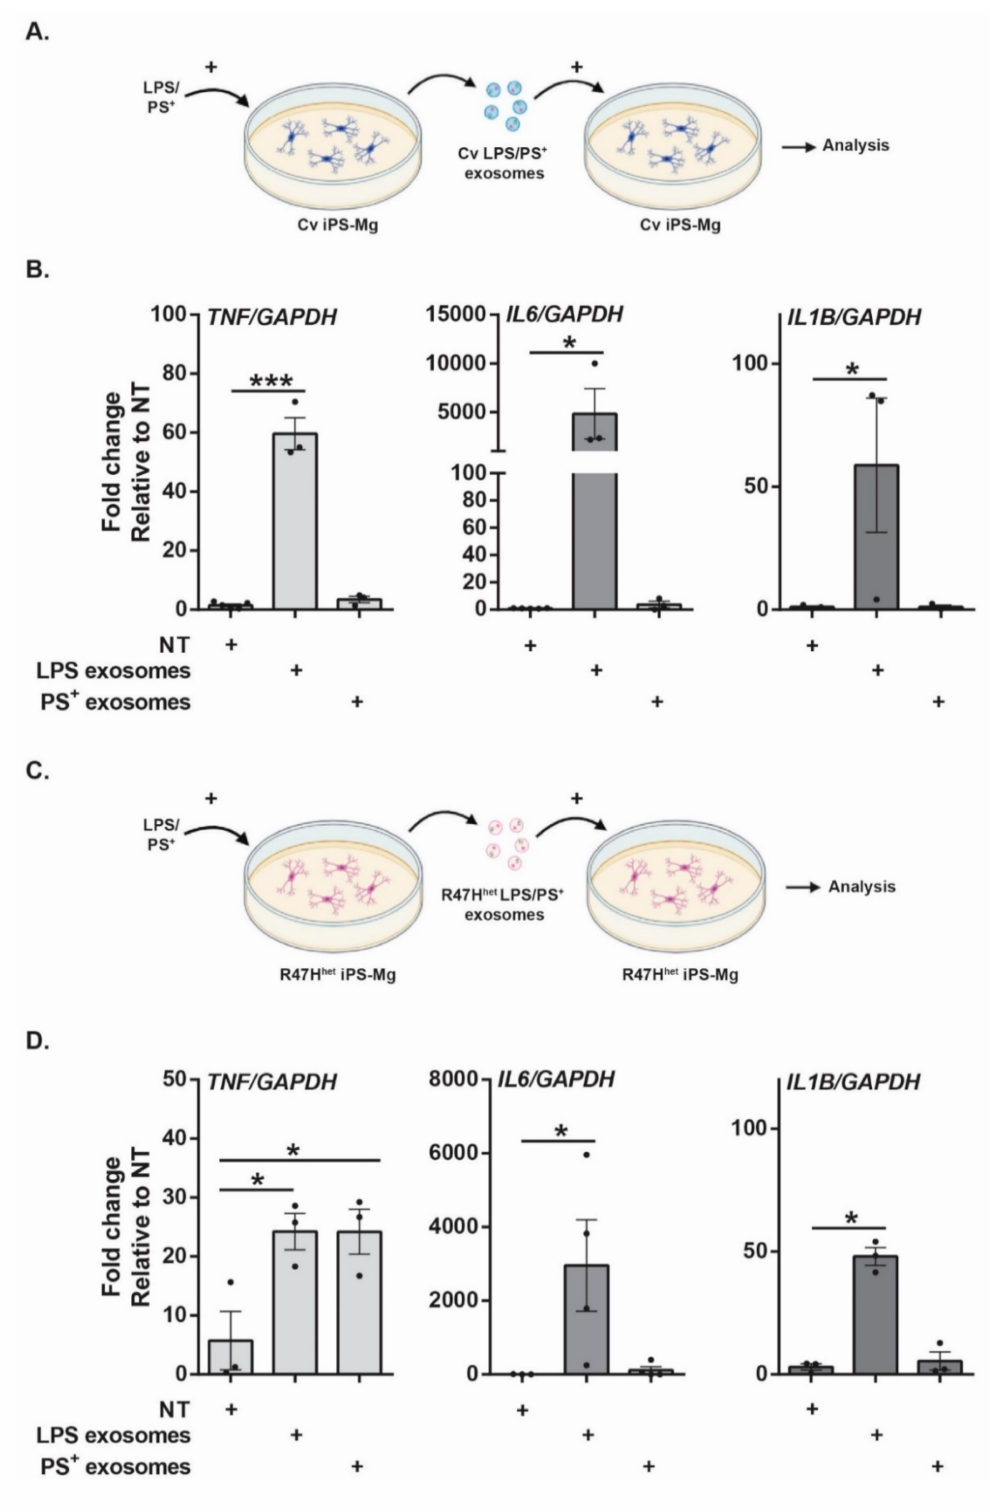
Figure 4. Microglial exosomes can activate naïve microglia. Based on the previous analysis (Figure 3), which showed large changes in the immune cluster following activation of iPS-Mg with LPS, the effect of iPS-Mg exosomes on naïve iPS-Mg was measured, specifically, the ability of exosomes from LPS activated iPS-Mg to transmit this information to naïve iPS-Mg. The experimental setup for ( B , D ) is shown in ( A , C ), respectively. The expression levels of TNF, IL6 and IL1B were determined by qPCR and are shown for Cv iPS-Mg exposed to Cv exosomes ( B ) and for R47H het iPS-Mg exposed to R47H exosomes ( D ). N = 3 separate experiments with one-way ANOVA. * p < 0.05, *** p <